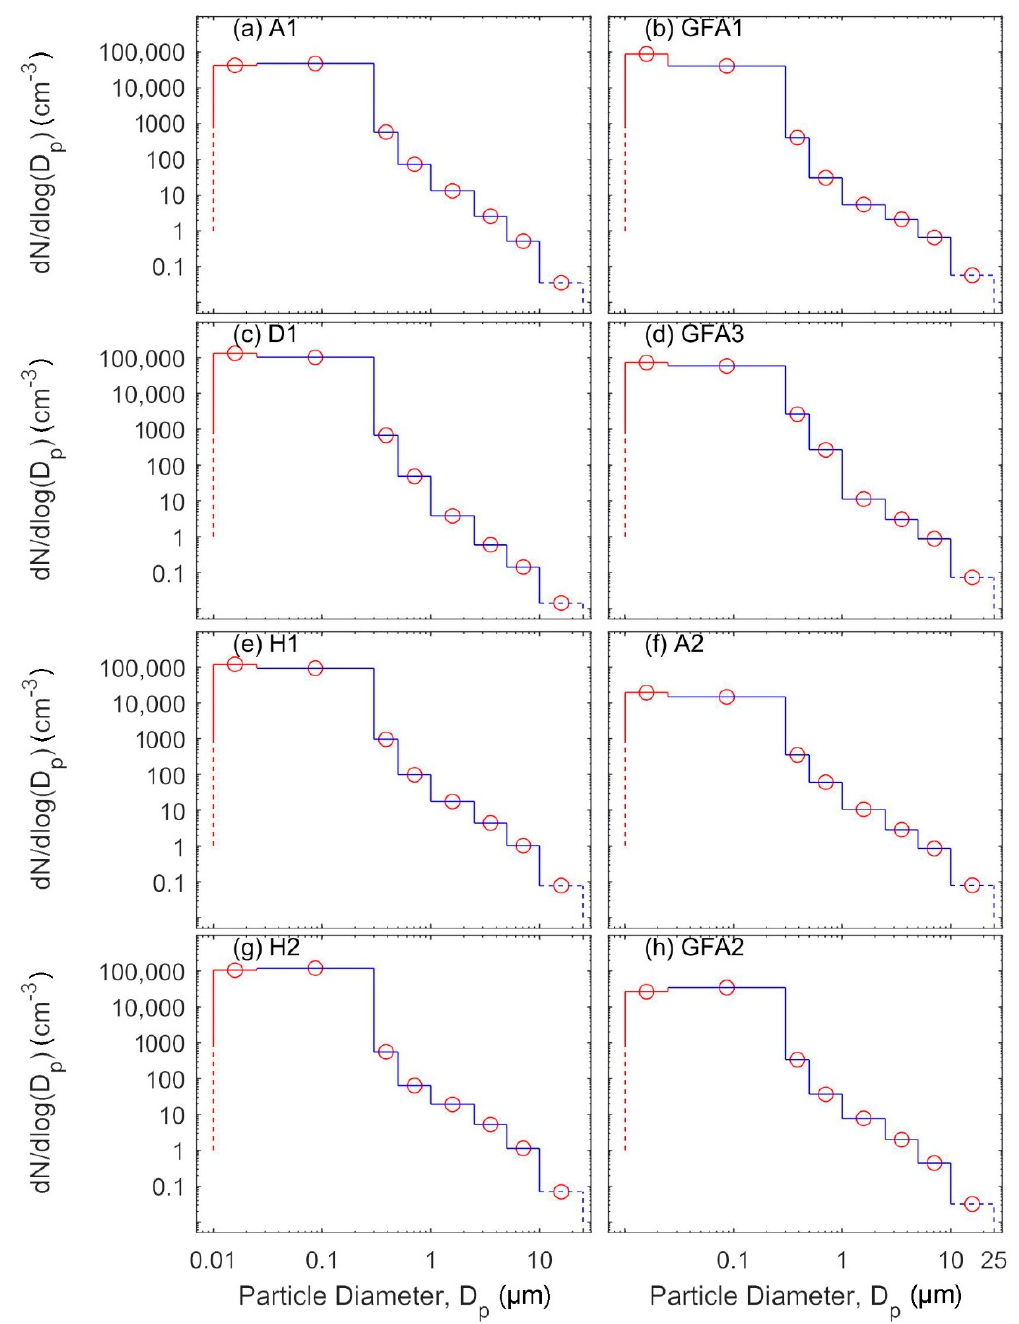
Figure 6. Mean particle number size distributions calculated for the entirety of the winter measurement campaign at each dwelling: ( a ) apartment A1, ( b ) ground floor apartment GFA1, ( c ) duplex D1, ( d ) ground floor apartment GFA3, ( e ) house H1, ( f ) apartment A2, ( g ) house H2, and ( h ) ground floor apartment GFA2.